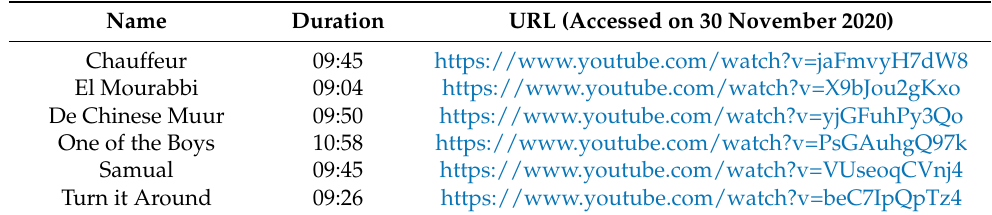
Table 1. Description of shown movie clips, categorized by name, duration and